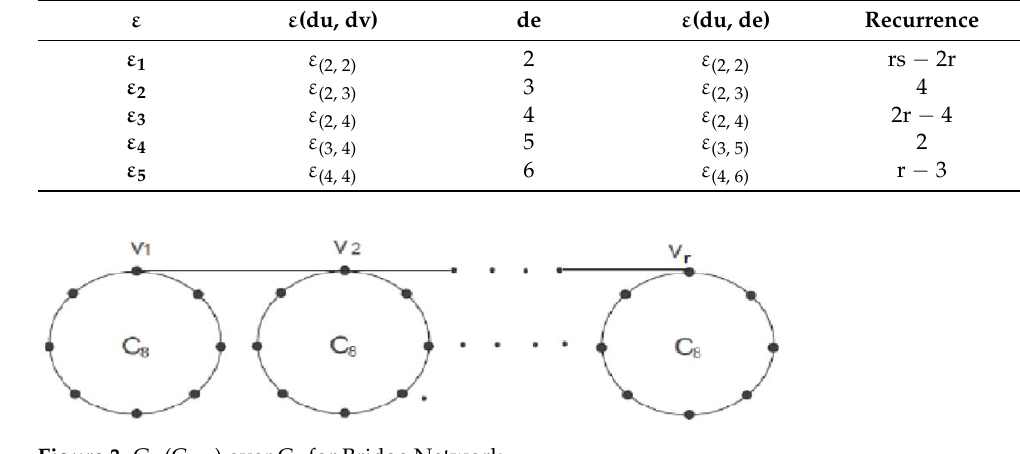
Figure 2. Result of ISO index for bridge networks of trees .